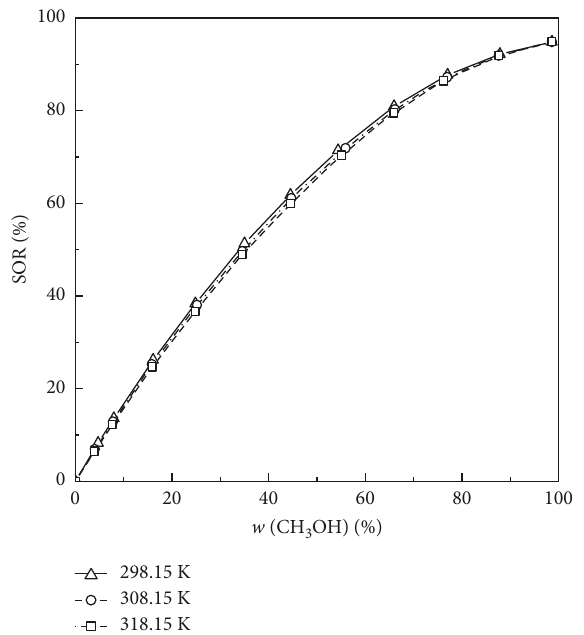
Figure 7: Salting-out rate (SOR) versus methanol content for the ternary system (NaCl + CH 3 OH + H 2 O) at 298.15, 308.15, and 318.15K; ( △ ), experimental point at 298.15K; ( ○ ), experimental point at 308.15K; ( □ ), experimental point at Table 4: Parameters of CNIBS/R-K model for solubility in solvent mixtures.